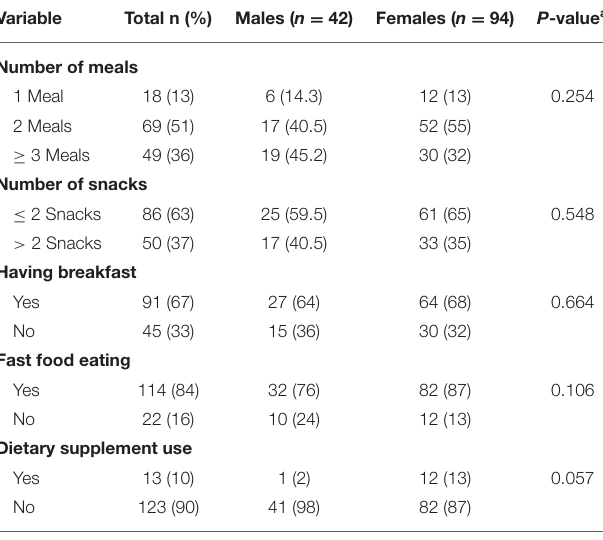
TABLE 3 | Dietary intake and pattern of college students stratified by gender ( n = 136).